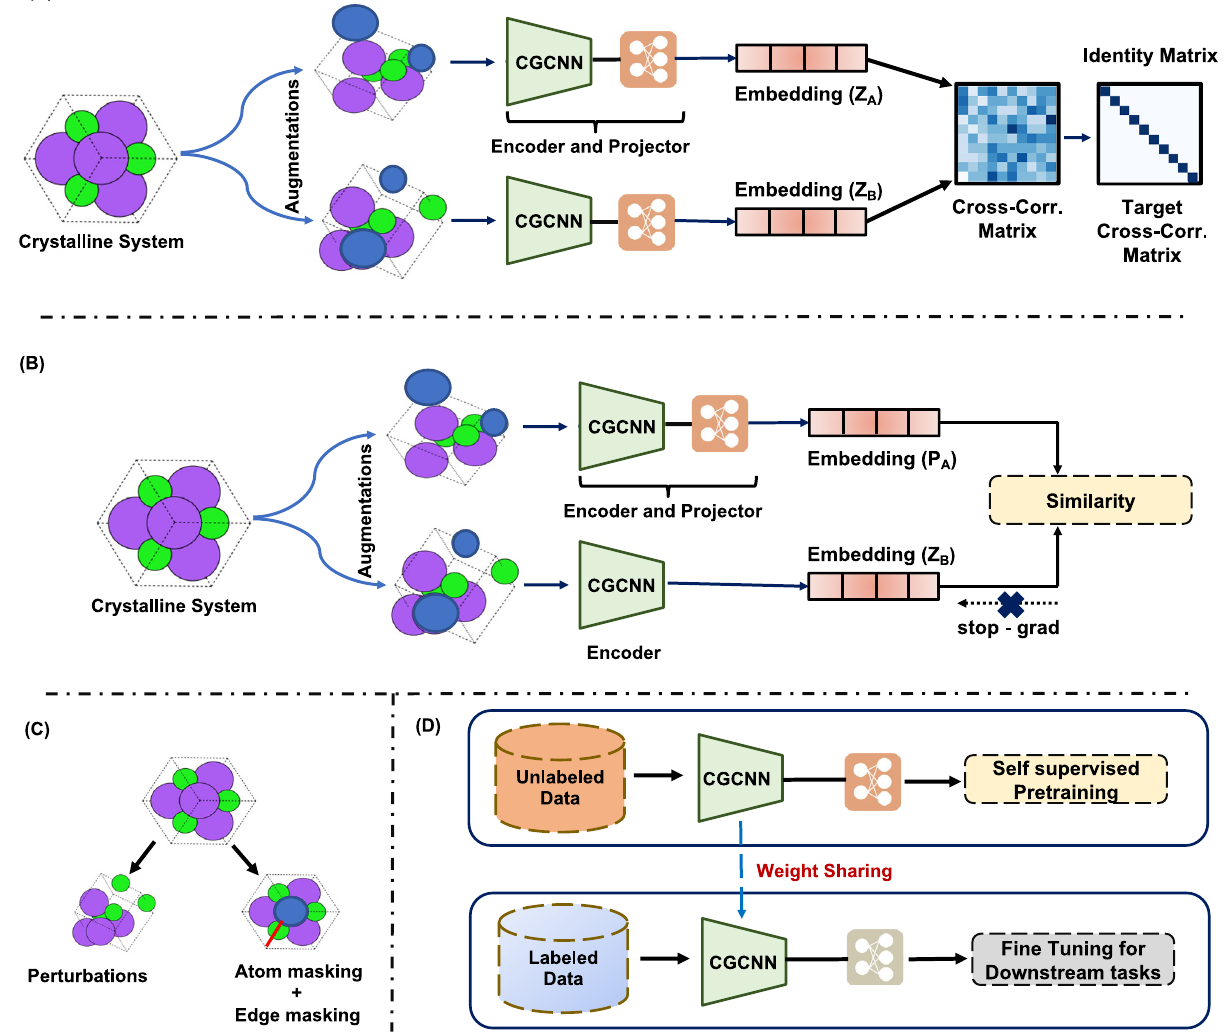
Fig. 1 Overview of the crystal twins (CT) framework. We propose two methodologies for SSL pre-training based on the Barlow Twins loss and SimSiamese loss function. The CT framework takes the structural fi le (CIF) as the input and then augments the structure to create two different augmented instances. ( A ) In CT Barlow , each instance is passed to the CGCNN graph encoder followed by a projector to generate embedding. The pre-training objective aims to maximize the cross-correlation between the two embeddings. ( B ) The CT SimSiam , each instance is passed through same CGCNN encoder branch to generate embeddings. One branch has an projector MLP head after the encoder and the other branch has stop-gradient operation. The pre-training objective is to maximize similarity between the embeddings. ( C ) To create augmented instances, three augmentation techniques are used in this work: random perturbations, atom masking, and edge masking. ( D ) In the pre-training stage we trained using SSL. In the fi ne-tuning stage, the pre-trained weights are shared with the encoder (CGCNN) which is trained to predict the material